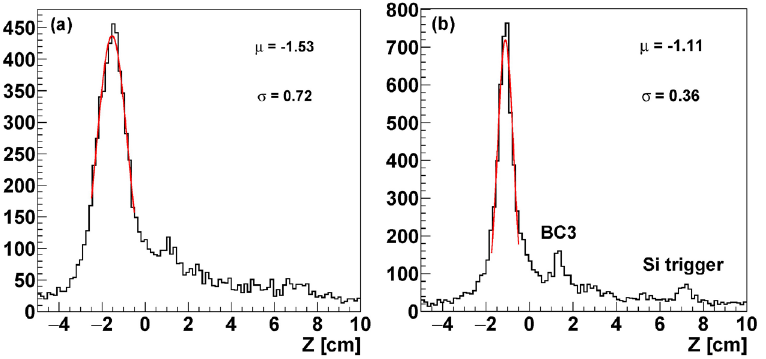
Fig. 3. Distribution of z-coordinates of reconstructed vertices before (a) and after (b)